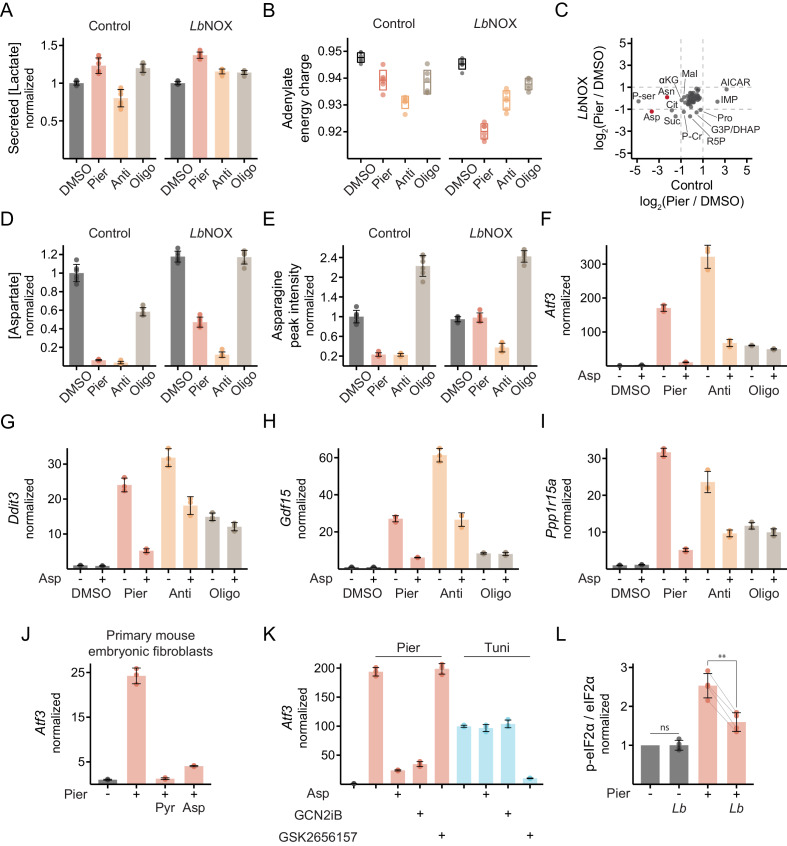
Additional data on metabolic consequences that trigger the ISR in myoblasts.(A) Secreted [lactate] following 2 hr inhibitor treatments in control or LbNOX cells. Data is normalized to DMSO separately in each cell line. Mean ± SD, N = 6 from three experiments (expanded version of Figure 4A). (B) Adenylate energy charge following 1 hr treatments in control or LbNOX cells. Mean ± SD, N = 5–6 from two experiments (expanded version of Figure 4B). (C) Scatter plot of intracellular metabolite fold-changes between piericidin and DMSO in control cells (x-axis) or LbNOX cells (y-axis). N = 3 replicates (same data as in Figure 4C). (D) Intracellular [aspartate] following 1 hr treatments in control or LbNOX cells. Mean ± SD, N = 6 from two experiments (expanded version of Figure 4D). (E) Peak intensity of intracellular asparagine following 1 hr treatments in control or LbNOX cells. Mean ± SD, N = 6 from two experiments (expanded version of Figure 4E). (F)-(I) qPCR of ISR-related transcripts following 10 hr treatments, with or without aspartate, in control cells. Data is presented as fold-change from DMSO without aspartate. Mean ± SD, N = 3. Ppp1r15a, protein phosphatase 1 regulatory subunit 15A. (J) qPCR of Atf3 following 10 hr piericidin treatment, with or without pyruvate or aspartate, in primary mouse embryonic fibroblasts. Data is presented as fold-change from DMSO (-). Mean ± SD, N = 3. (K) qPCR of Atf3 following 10 hr piericidin or tunicamycin treatment, with or without aspartate, GCN2iB or the PERK inhibitor GSK2656157, in control cells. Data is presented as fold-change from DMSO. Mean ± SD, N = 3. (L) Ratio of p-eIF2α to total eIF2α, measured by western blot, following 6 hr piericidin treatment in LbNOX cells. LbNOX expression was induced only where indicated. Data is normalized separately in each blot to the DMSO-treated sample not expressing LbNOX. Mean ± SD, N = 4 from four experiments. A one-sample t-test was used to examine whether the mean of DMSO-treated samples expressing LbNOX differed from 1, and Welch’s t-test (two-tailed, paired by blot) was used to compare the piericidin-treated samples with and without LbNOX expression. Holm’s correction was then applied. ns, p>0.05; **, p<0.01.